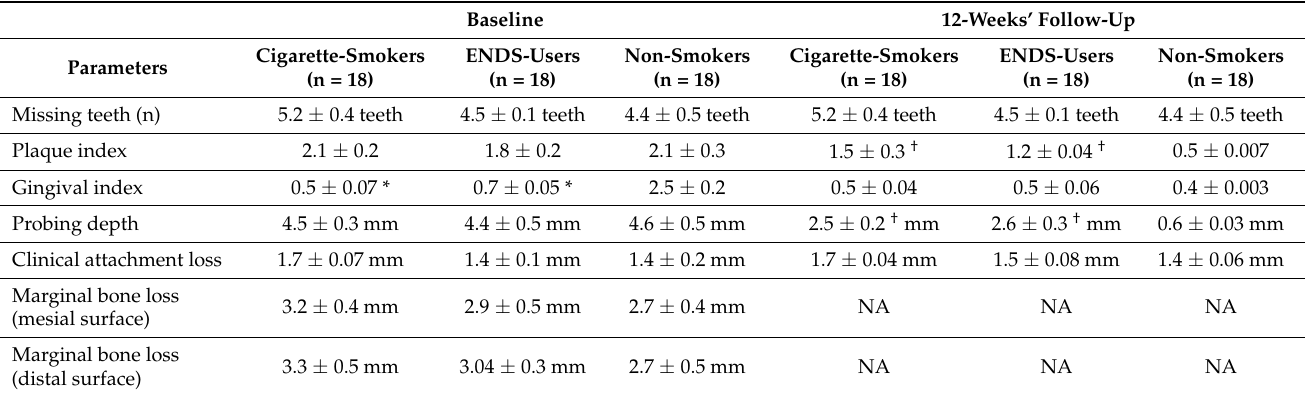
Table 2. Periodontal status at baseline and at 12 weeks of follow-up.